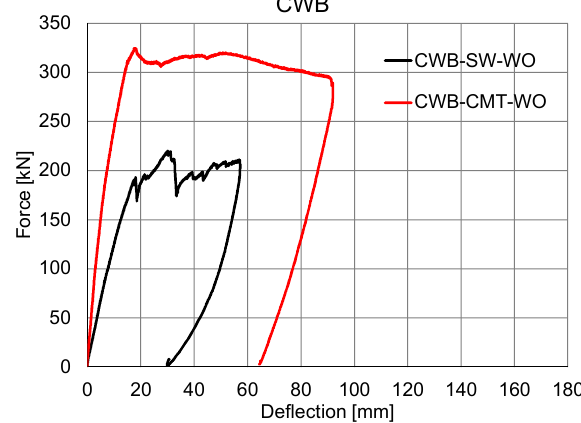
Figure 8. Comparison of CWBs with web openings.